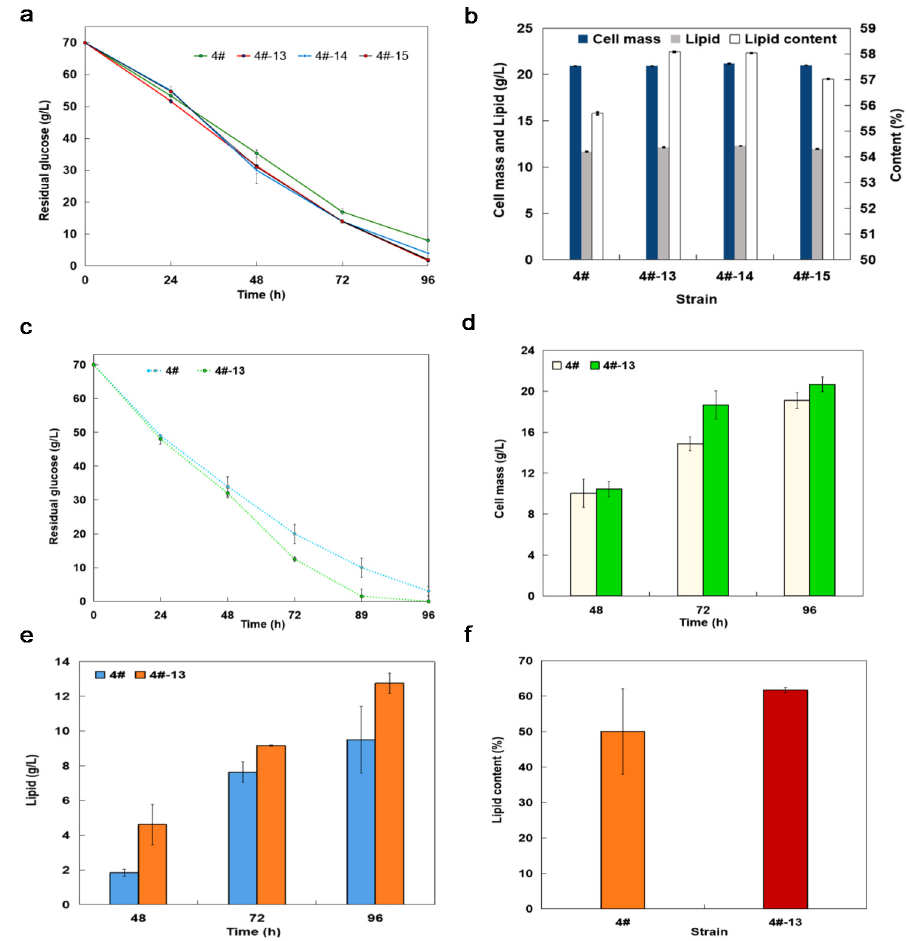
Figure 3. Lipid production with 50 mL cell culture in 250 mL shaking flasks by R. toruloides strains. Results of ( a ) residual glucose and ( b ) cell mass, lipids and lipid contents of initial screening cultures. Experiments were done in three technical replicates for 4# and with three colonies in three technical replicates for each recombinant strain. Data are means ± SD of three replicates. Results of ( c ) residual glucose, ( d ) cell mass, ( e ) lipids, and ( f ) lipid contents of lipid production cultures are done in two technical replicates. Data are means ± SD of two replicates. Energies 2020 , 13 , x FOR PEER REVIEW